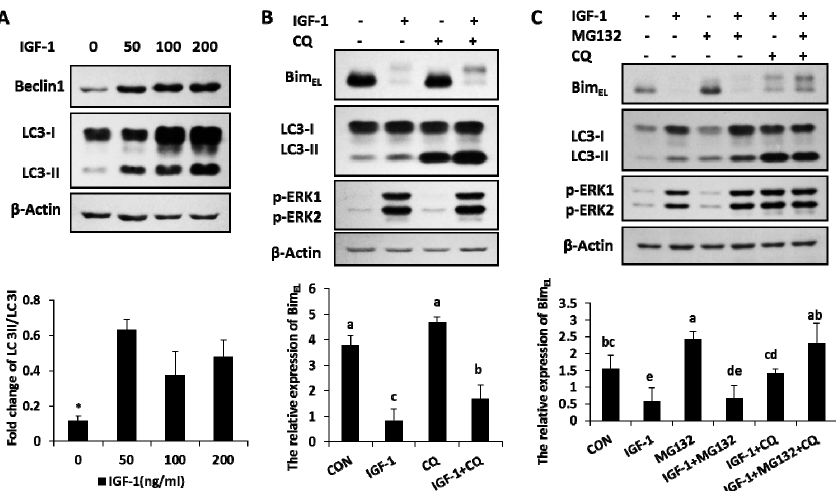
Figure 3. Autophagy was activated by IGF-1, and both blocking the autophagy flux turnover and